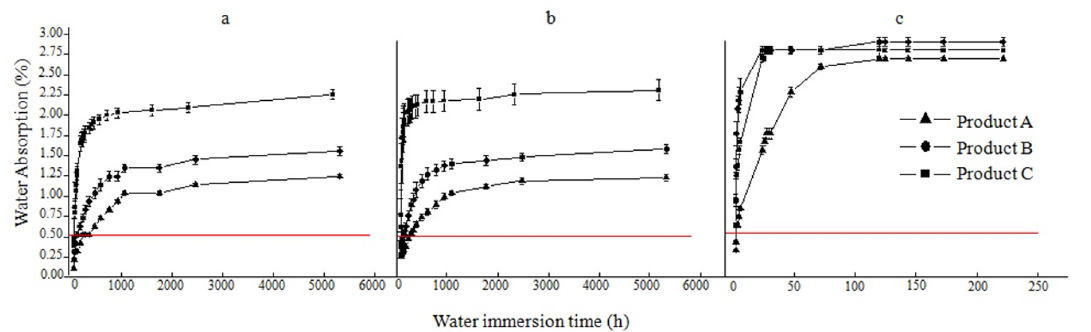
Figure 5. WA in function of the water immersion time obtained by the three evaluated methods: (a) ISO 10545, (b) ASTM C373 and (c) vacuum method proposed by ISO. longer water immersion time is needed to achieve saturation.